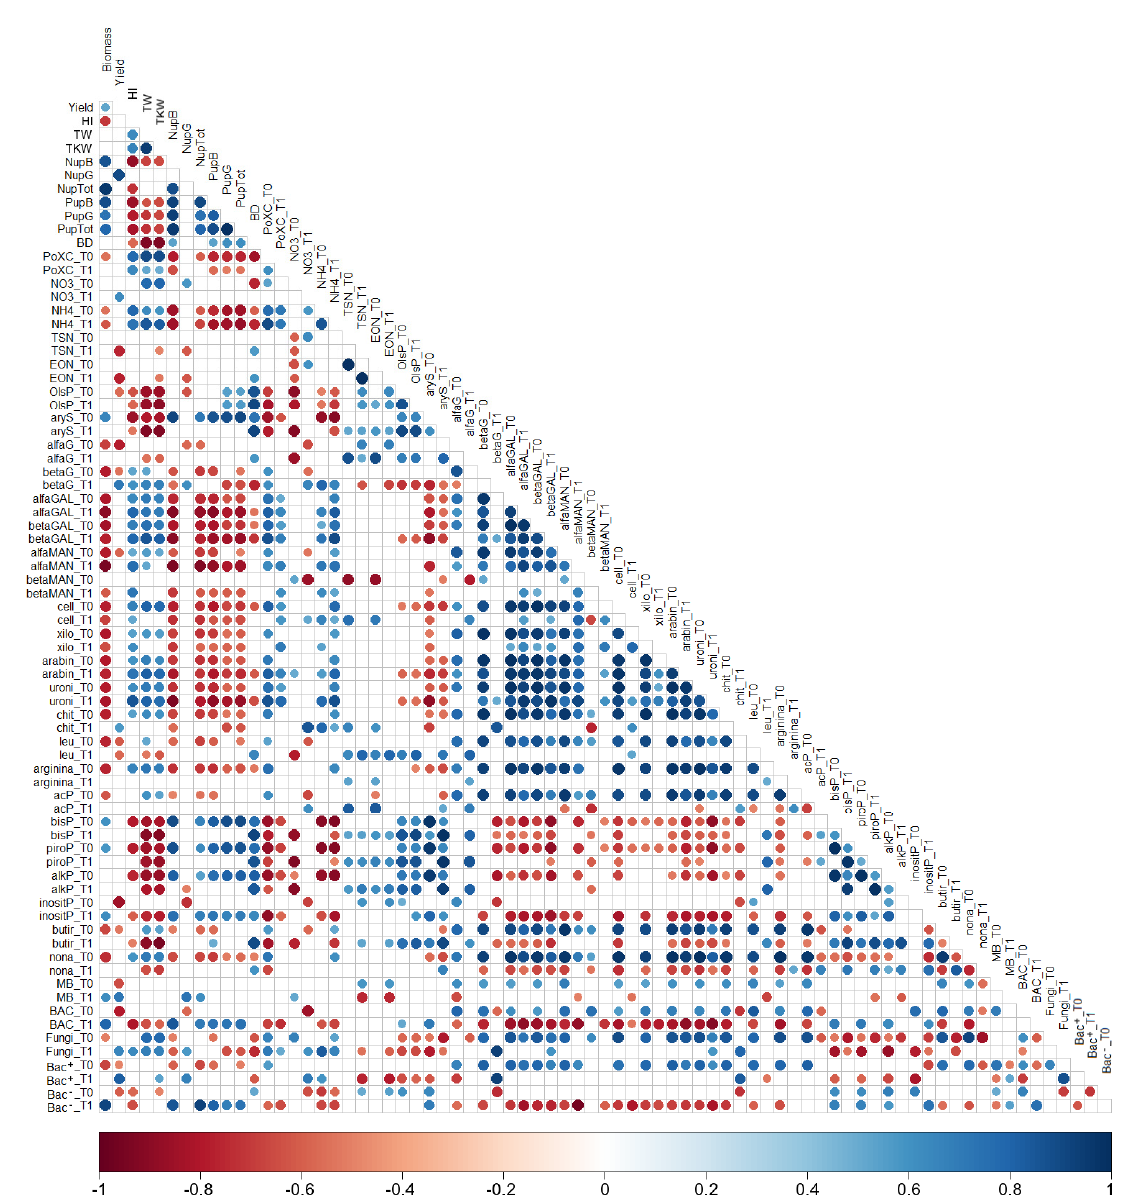
Figure 8. Pairwise Pearson’s correlation analysis. The circle indicates the significant correlation among considered variables ( p < 0.05) described in the M&M section. Blue and red colours indicate positive and negative correlations, respectively, while the circle size reflects the intensity of correlation (r-value).